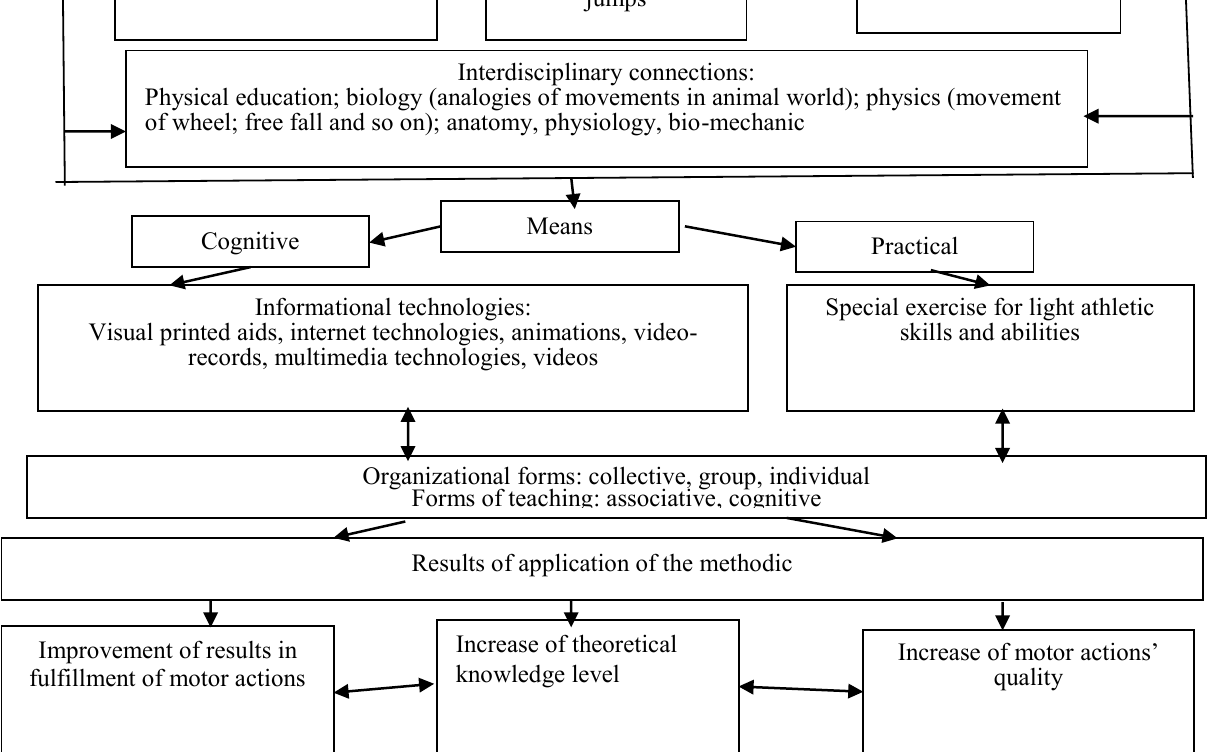
Fig.1. Model of authors’ methodic of motor skills’ and abilities’ training for senior forms pupils at light athletic